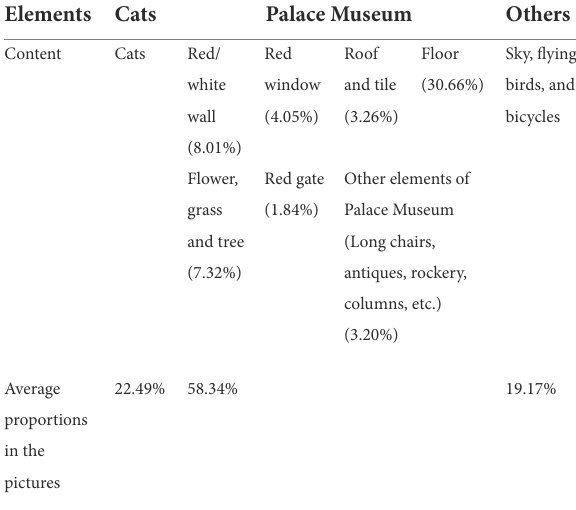
TABLE 1 Average proportions of composing elements in the 100